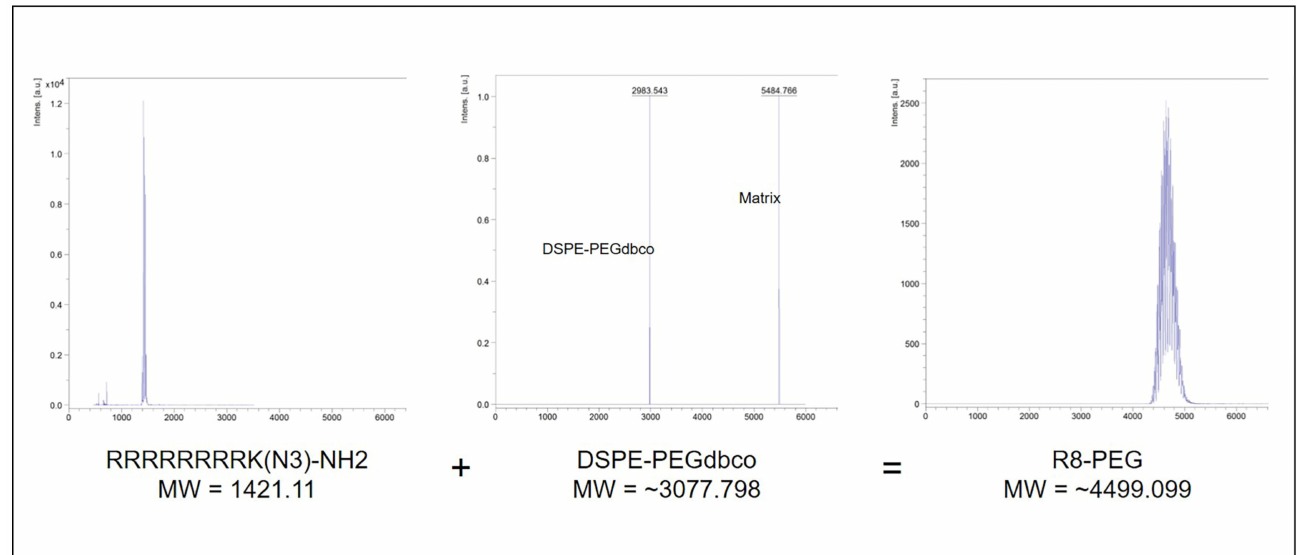
Figure 1. Mass spectroscopy confirmed R8 peptide conjugation to DSPE-PEGdbco via azide-alkyne cycloaddition reaction (i.e., click